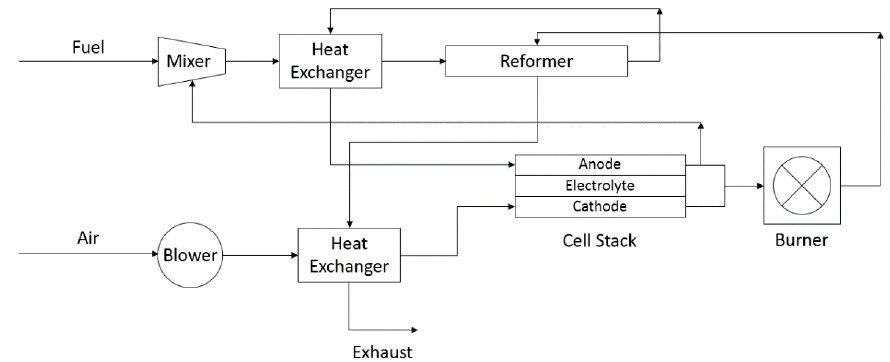
Figure 5. Flow chart of balance-of-plant (BOP) components/system operation (based on schematic from Reference [30]).